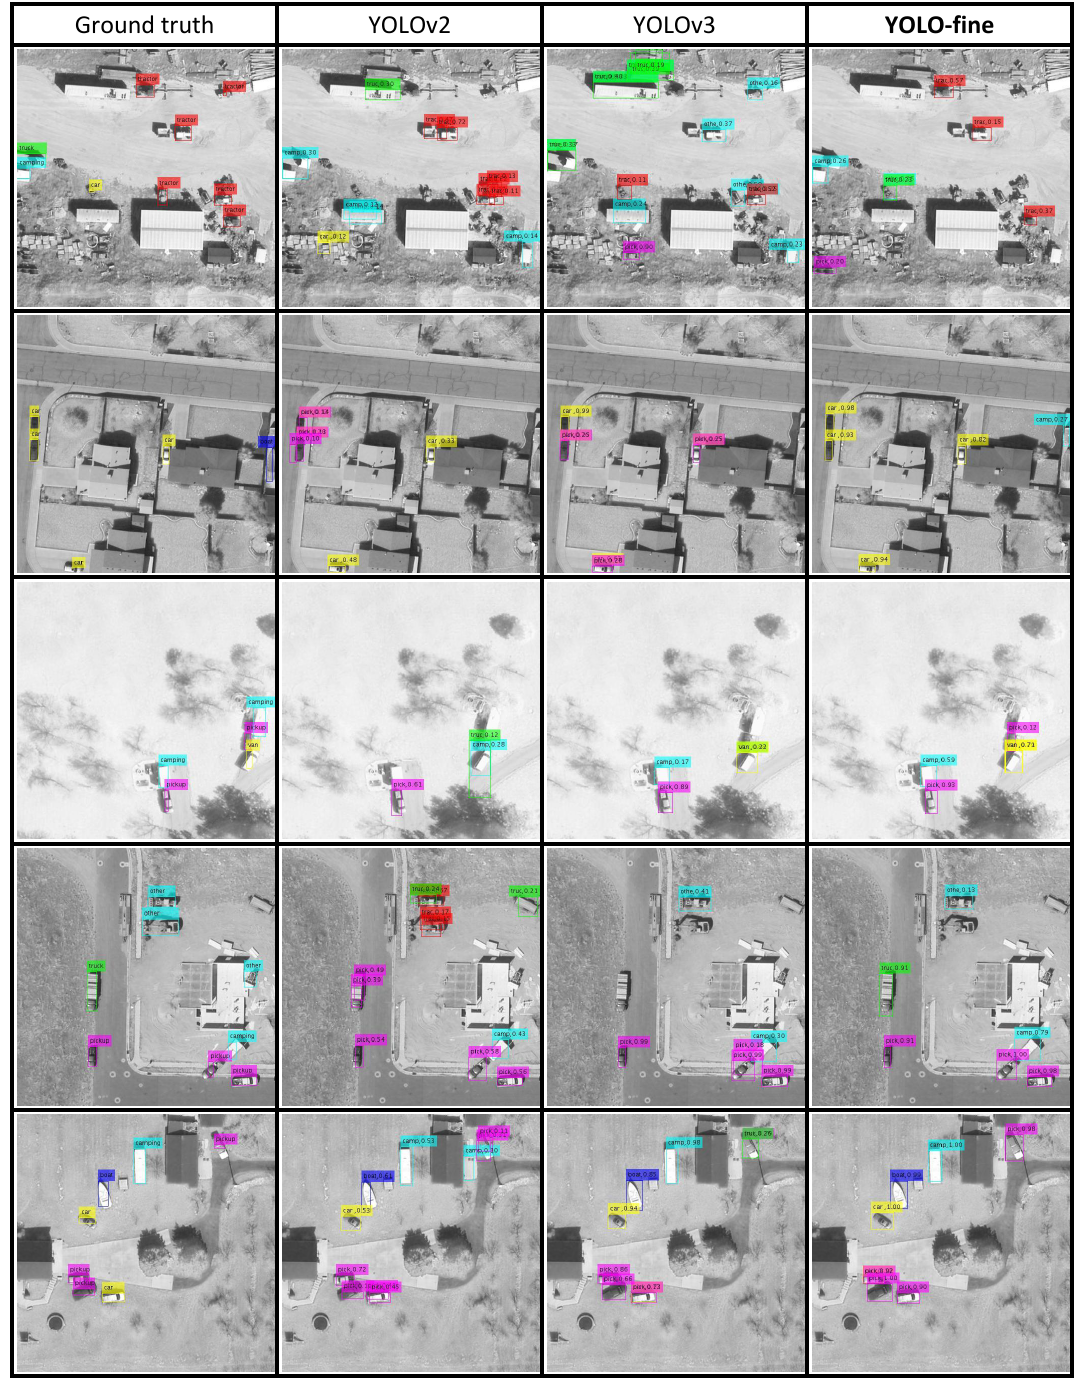
Figure 8. Illustration of detection results on VEDAI1024 (infrared